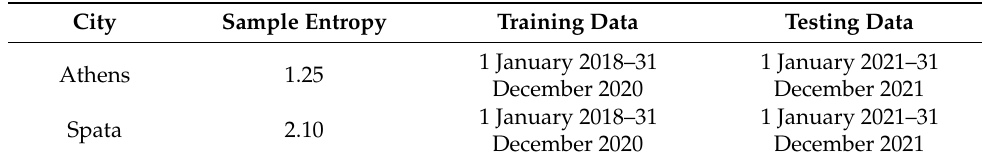
Table 1. Description of the sample entropy and data